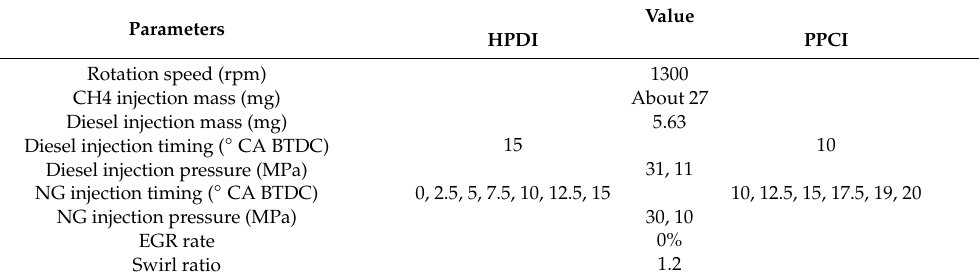
Table 3. Main simulation parameters of the two combustion modes.